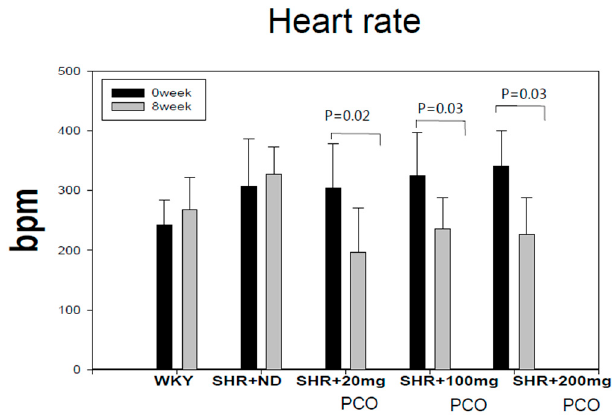
Figure 1. Changes in heart rate (HR) during eight weeks of policosanol supplementation. bpm, beats per minute; ND, normal diet; PCO, policosanol.